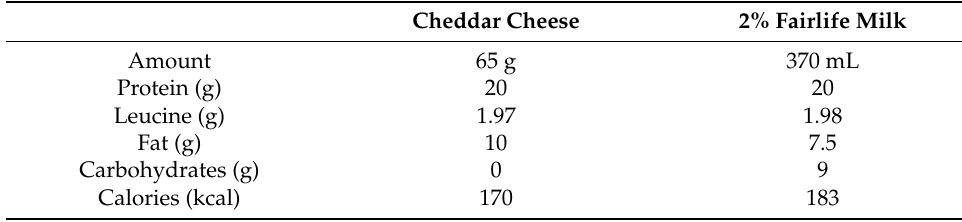
Figure 1. Overview of the crossover study experimental design. Table 2. Nutrient content of experimental products.